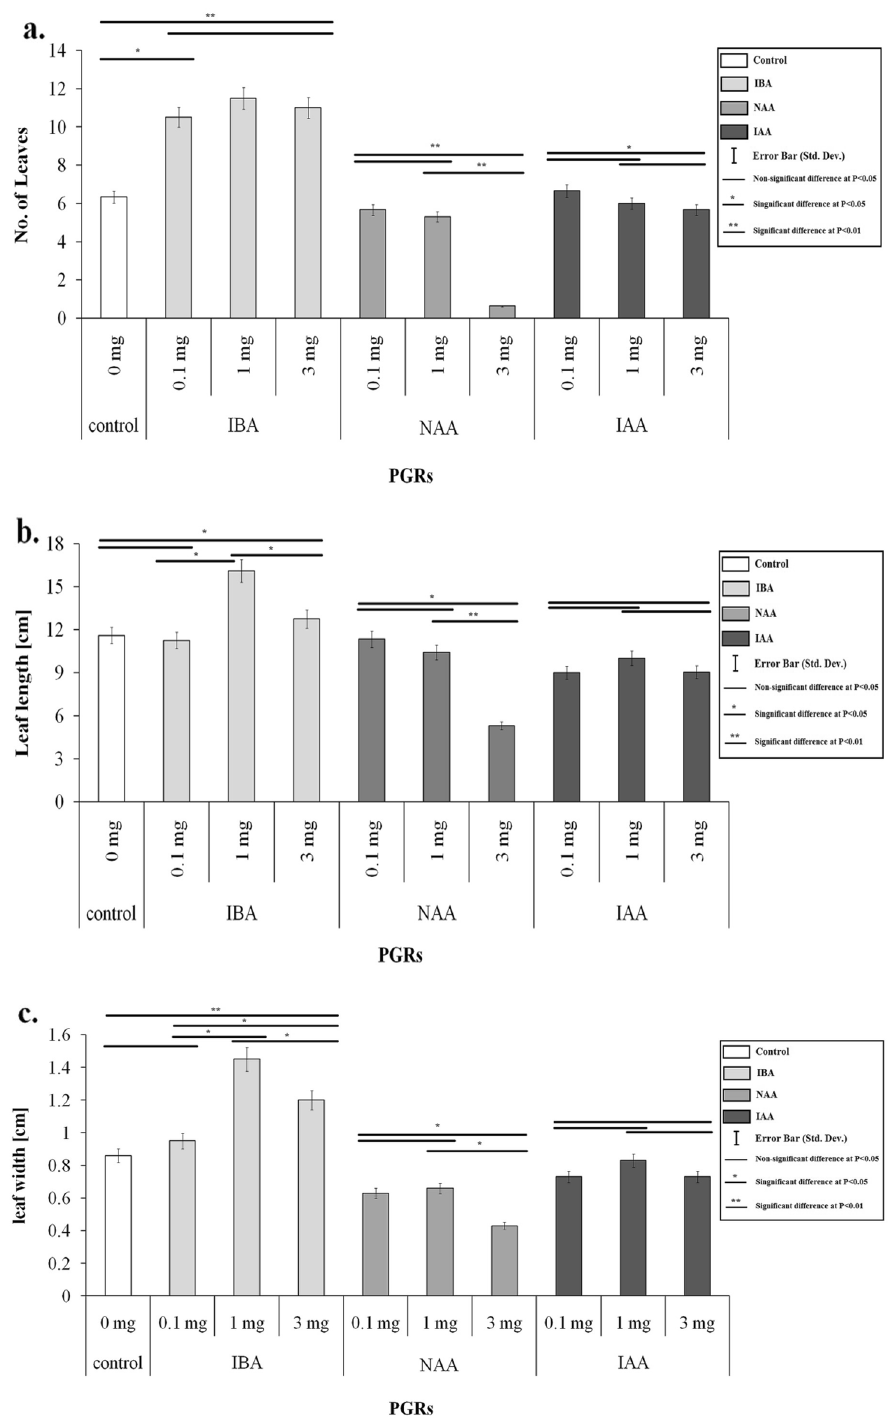
Figure 3. ( a ) Effect of PGRs on number of leaves ( b ) Effect of PGRs on leaf length ( c ) Effect of PGRs on leaf NAA had a significant negative effect (P < 0.05) noted on leaf width (Fig. 3c). IAA treatments had no influence (P > 0.05) on the leaf width. Media containing NAA alone (1.0 mg L −1 ) 28 and the addition of 2 mg L −1 IBA, 2 mg L −1 IAA 29 induced roots in pineapple plantlets cv. Smooth Cayenne. The solidified half-level MS medium containing 0.5 mg L −1 IBA and 0.5 mg L −1 NAA 30 noted better rooting. Medium comprising 0.5 mg L −1 IBA, 0.5 mg L −1 NAA 18 , and half-level MS medium containing 2.0 mg L −1 IBA 31 recommended for rooting in cv. Primavita, MD2 and Madhupur cultivars.